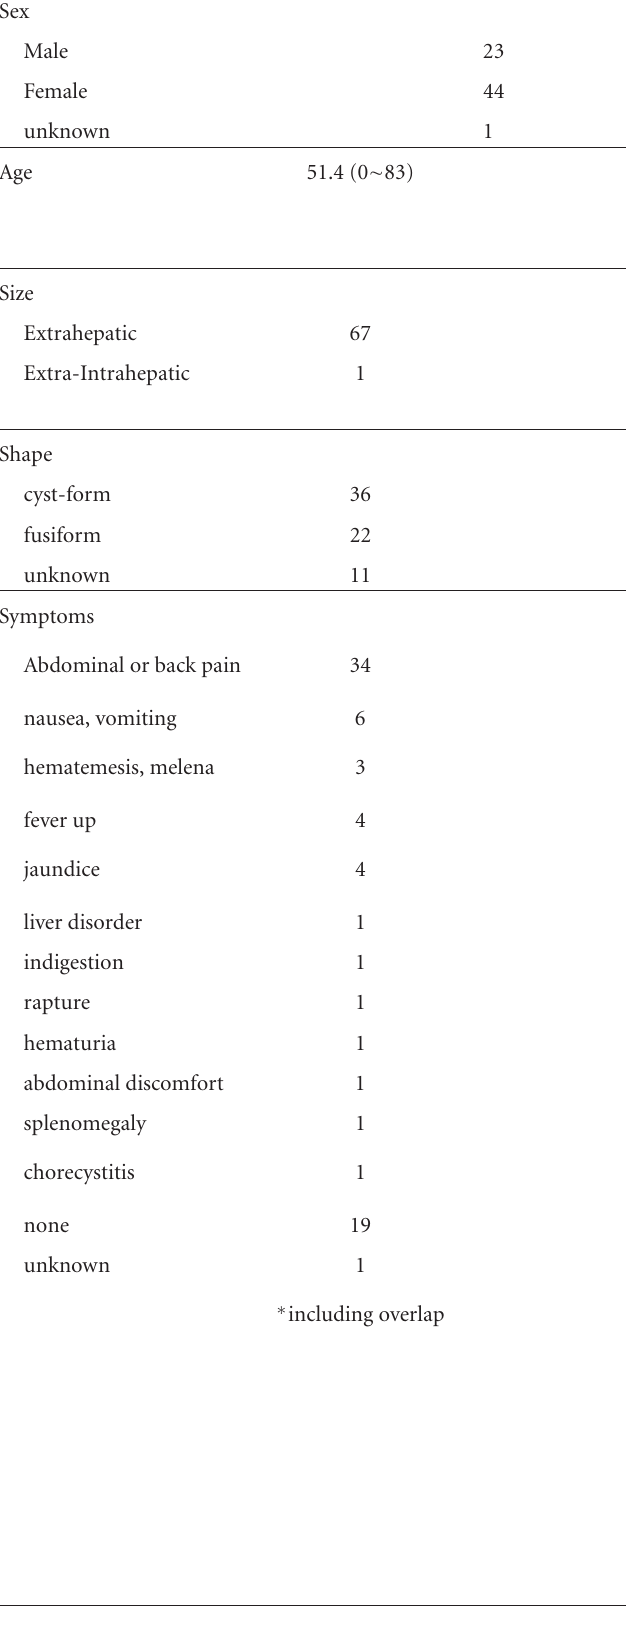
Table 1: Summary of the reported cases of portal vein aneurysm in English litelature (including our